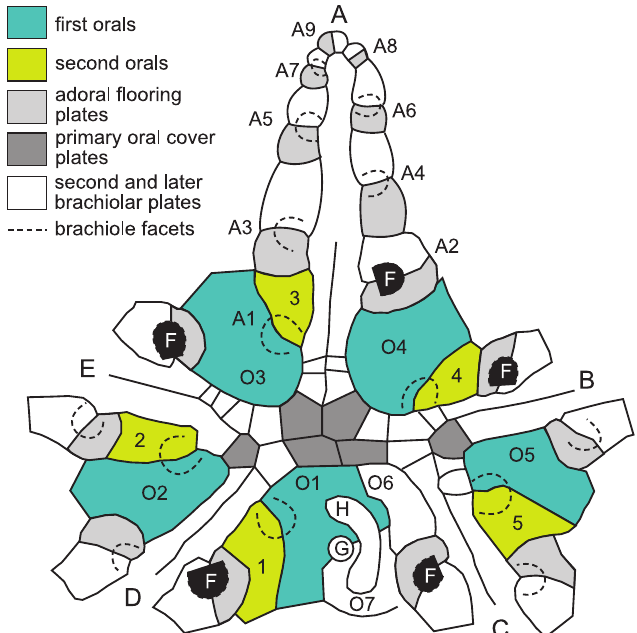
Fig. 5. Plating in the oral area and in ambulacrum A of the glyptocystitoid Lepadocystis moorei (Meek, 1871), Late Ordovician, Ohio, USA, showing interpretation of ambulacral growth and plate homologies. A–E, Carpenter (1884, 1891) ambulacra. Brachiole facets (F) are numbered (A1–A9) in am- bulacrum A in the order in which they formed during growth, which cannot be changed after initial development. Each brachiole facet is developed on a pair of floor plates, the adoral of which is shaded pale grey. These are the first brachiolar plates to form during growth and become modified as floor